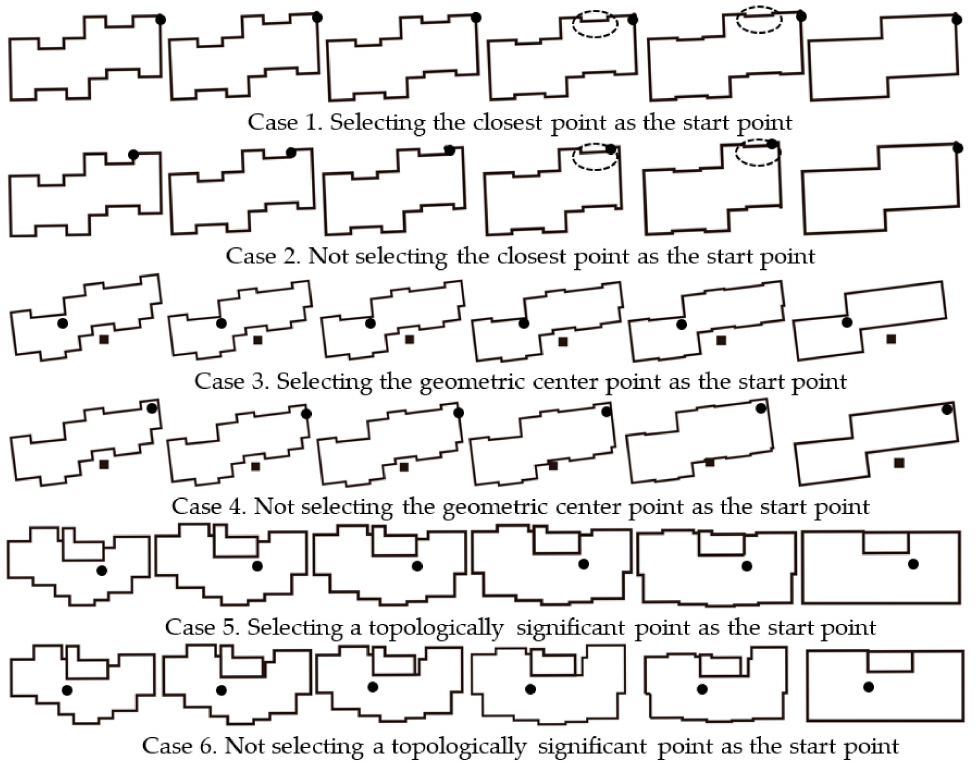
Figure 7. Morphing based on different start